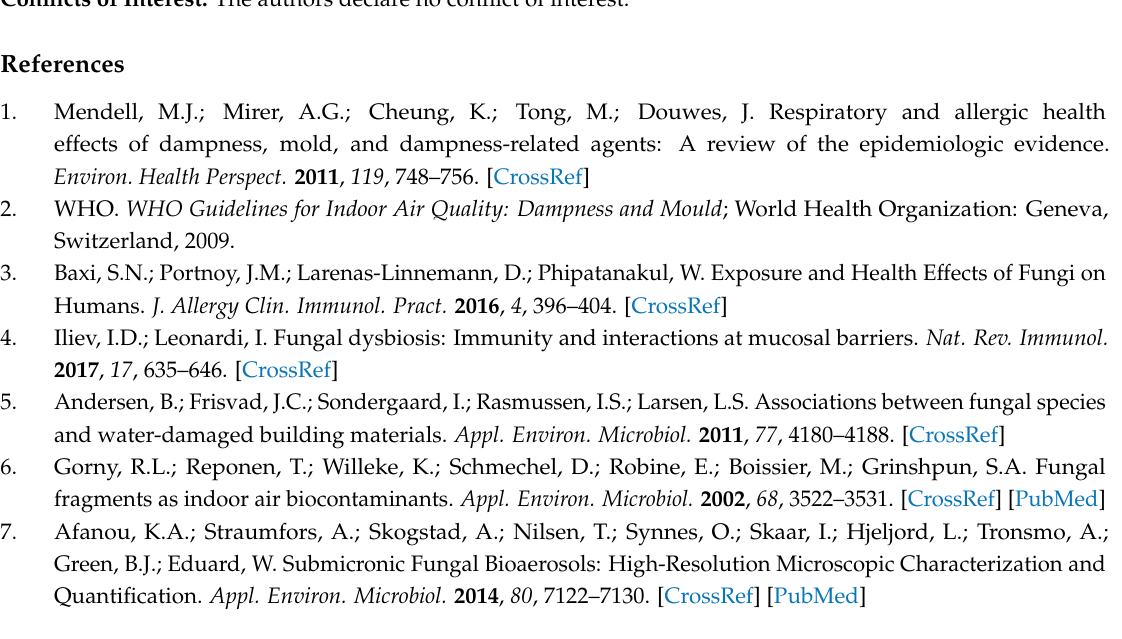
s1, Figure S1: Inhibition of A. fumigatus - or P. chrysogenum -induced cytokine/chemokine gene expression by TLR2 and TLR4 antagonist molecules. Figure S2: Time-dependent IL-1 β , TNF- α and IL-33 expression after exposure to untreated A. fumigatus spores and hyphal fragments. Figure S3: Time-dependent gene expression after exposure to X-ray treated A. fumigatus spores and hyphal